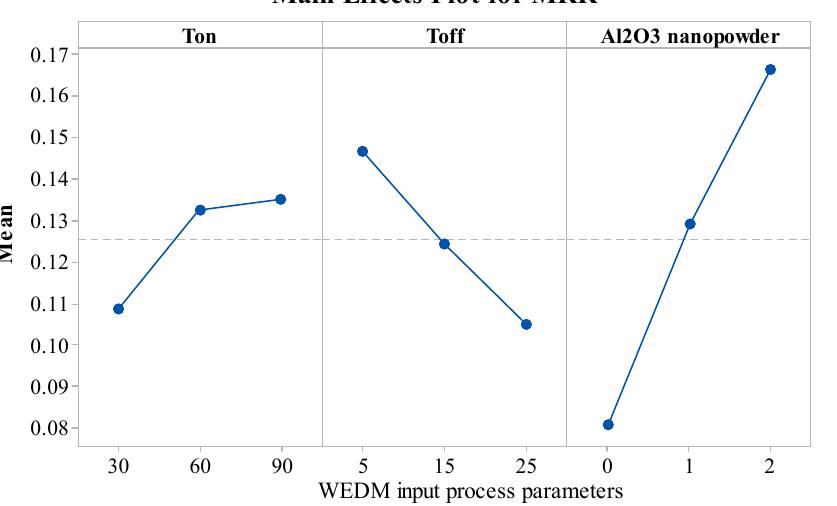
Figure 3. Influence of WEDM variables on MRR.